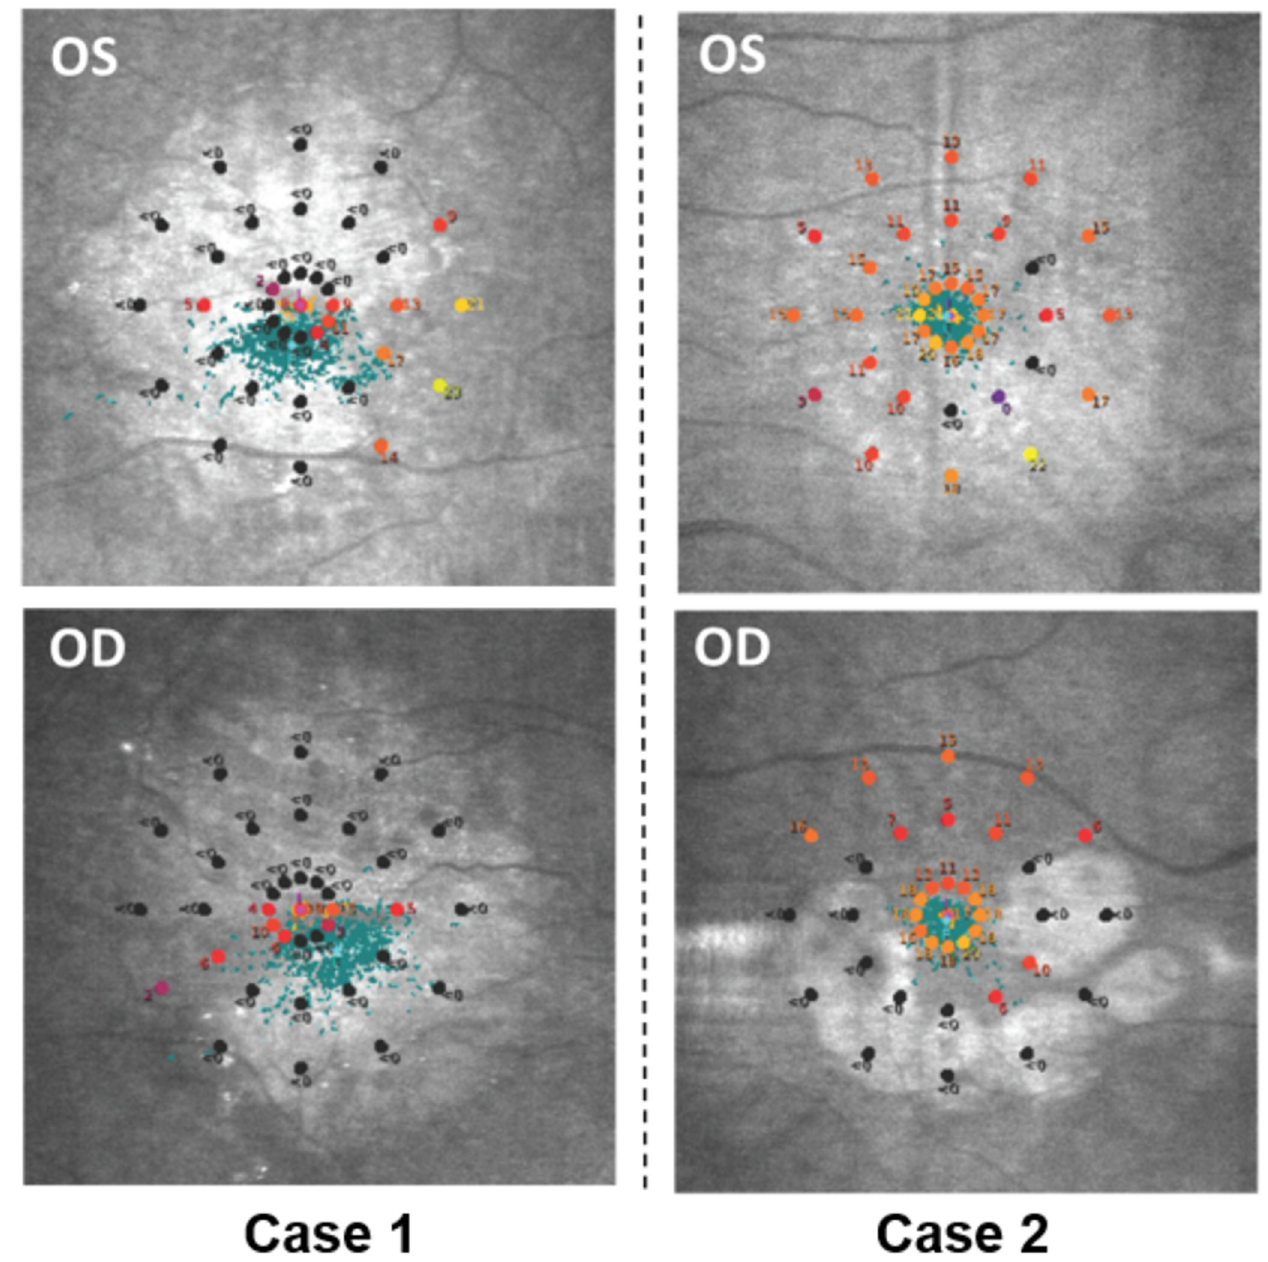
Fig 5. Microperimetry results for cases 1–2. Left eye (OS) and right eye (OD). The blue dots are the fixation points of the eye at time of measurement.